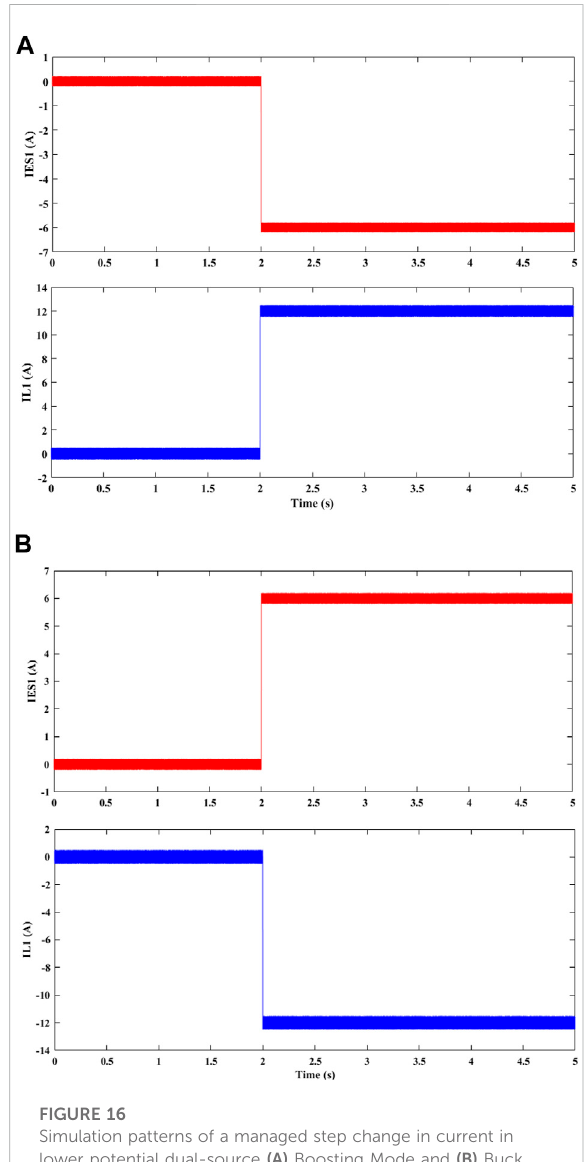
FIGURE 16 Simulation patterns of a managed step change in current in lower potential dual-source (A) Boosting Mode and (B) Buck